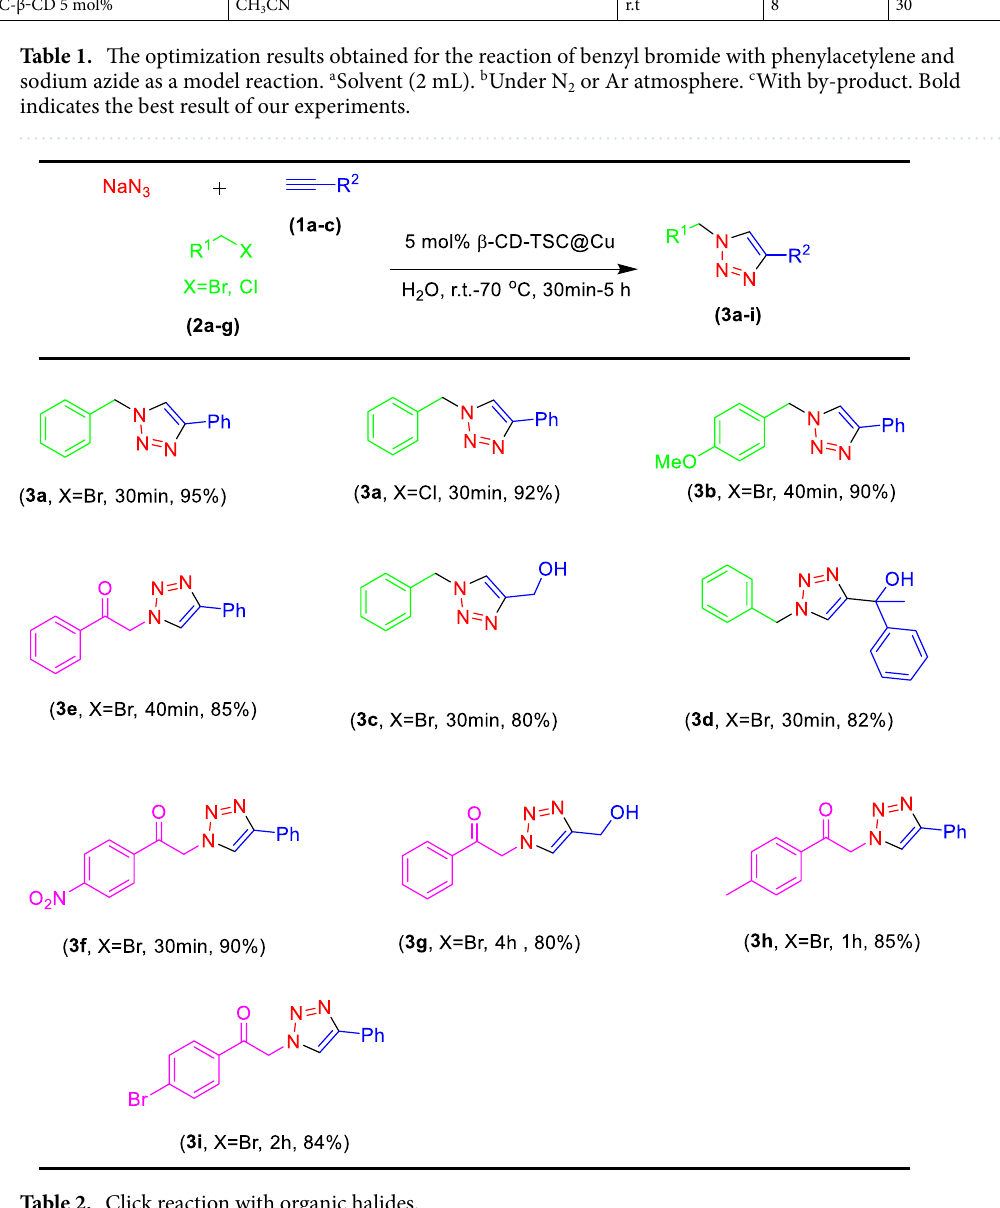
Table 2. Click reaction with organic